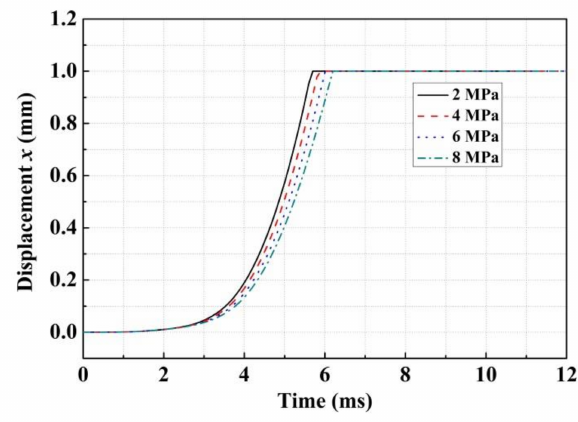
Figure 7. Dynamic response curves under different supply pressures ( u = 240 V, α = 45 ◦